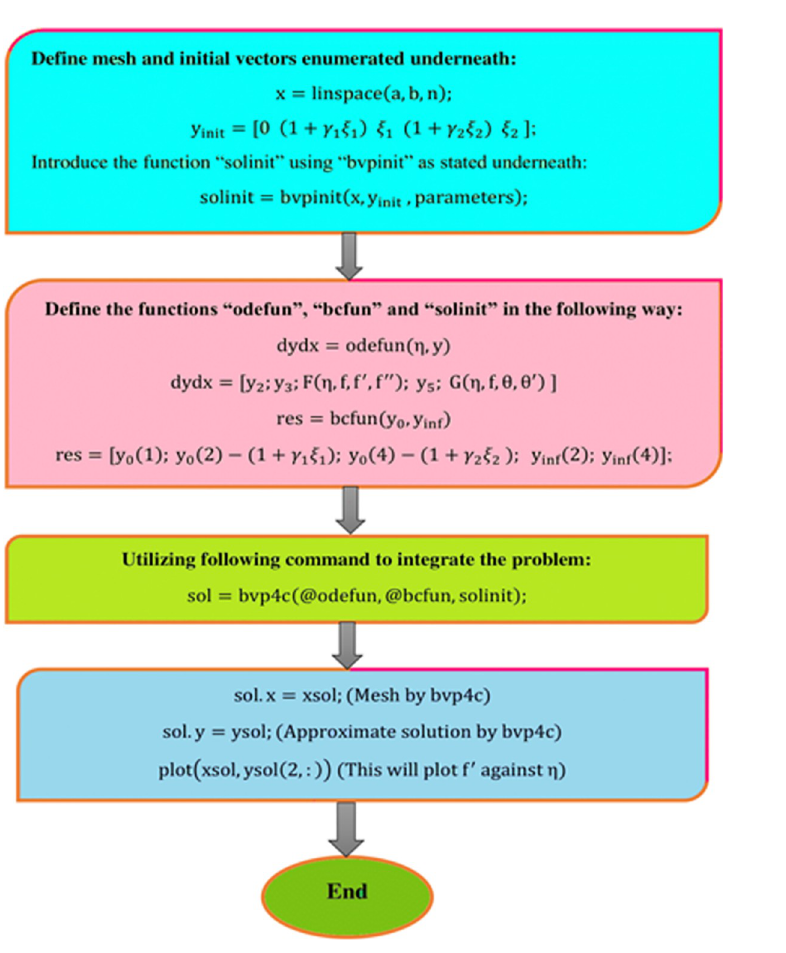
Fig 3. The bvp4c scheme’s flow chart method.